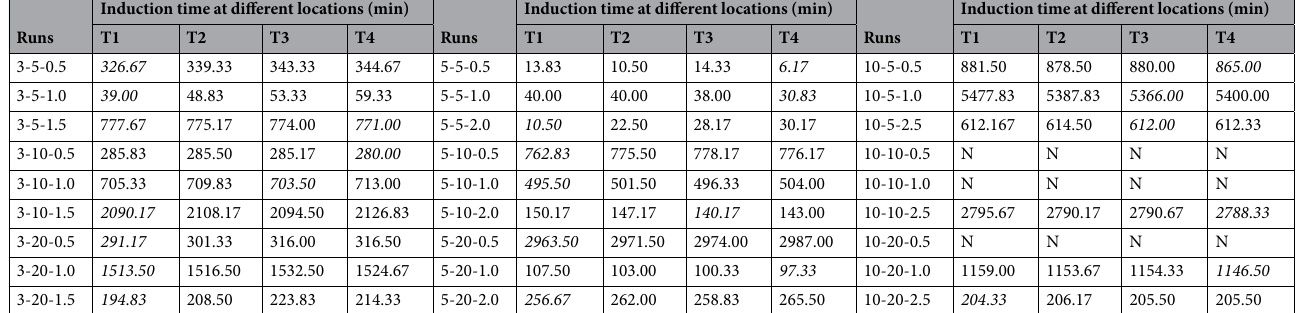
Table 2. Induction times at four locations within each experimental medium. These italic numbers symbolize the first nucleation